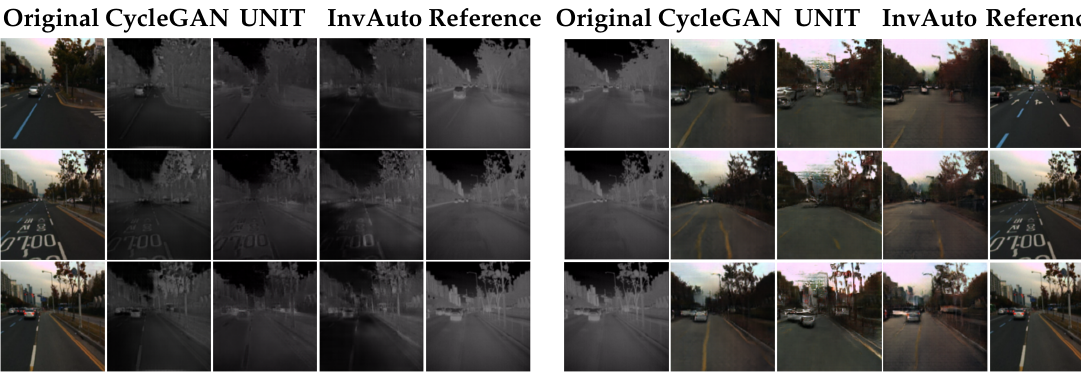
Figure 7. ( Left ) Day-to-thermal image conversion. Zoomed image is shown in Figure A7 in Appendix A. ( Right ) Thermal-to-day image conversion. Zoomed image is shown in Figure A8 in Appendix A.